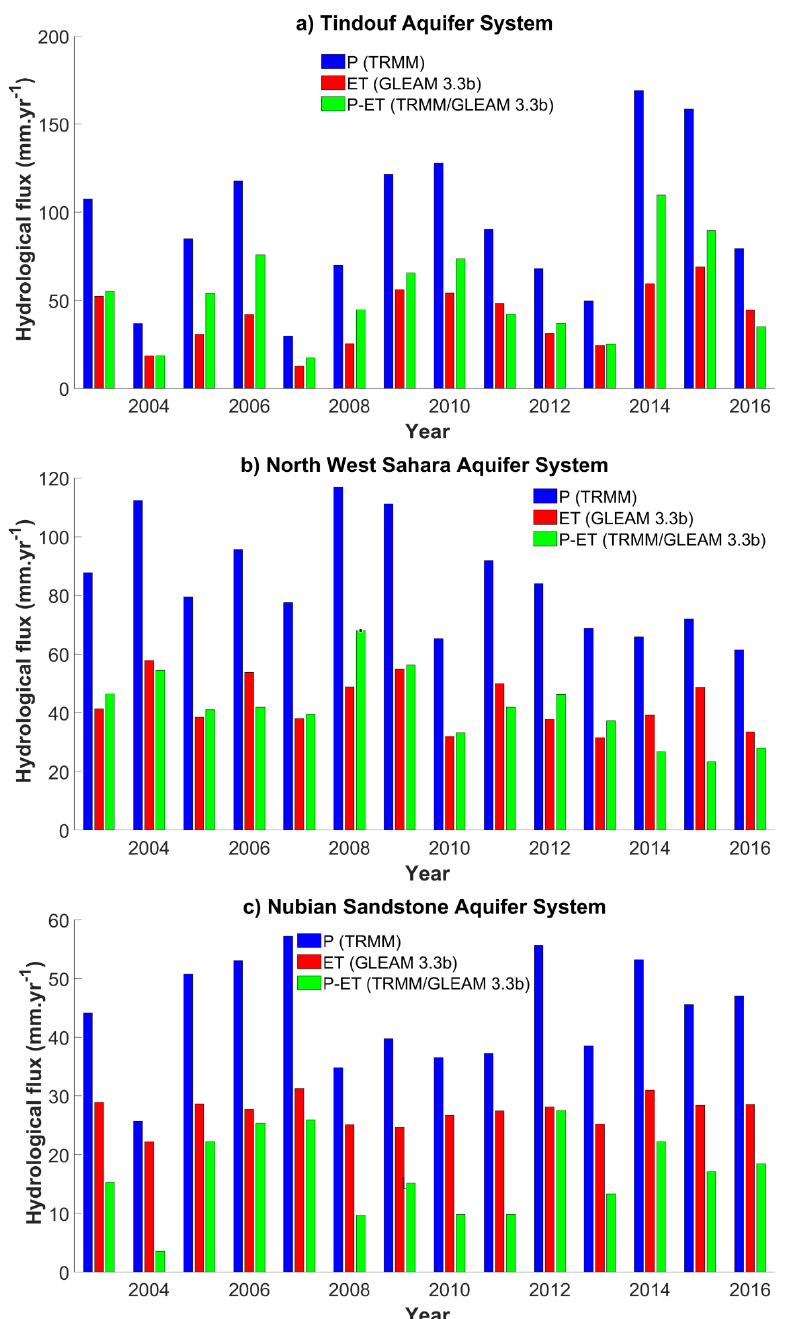
Figure 6. Time series of annual rainfall from Tropical Rainfall Measuring Mission (TRMM, blue), evapotranspiration (ET) from GLEAM 3.3b (red), precipitation minus evapotranspiration (P − ET) as the difference of the two former (green) between 2003 and 2016 for TAS ( a ); NWSAS ( b ); and NSAS ( c ). Maps of GW changes over 2003–2016 were obtained also applying a 13-month averaging window to the grids of groundwater anomalies determined using (3). These changes correspond to the